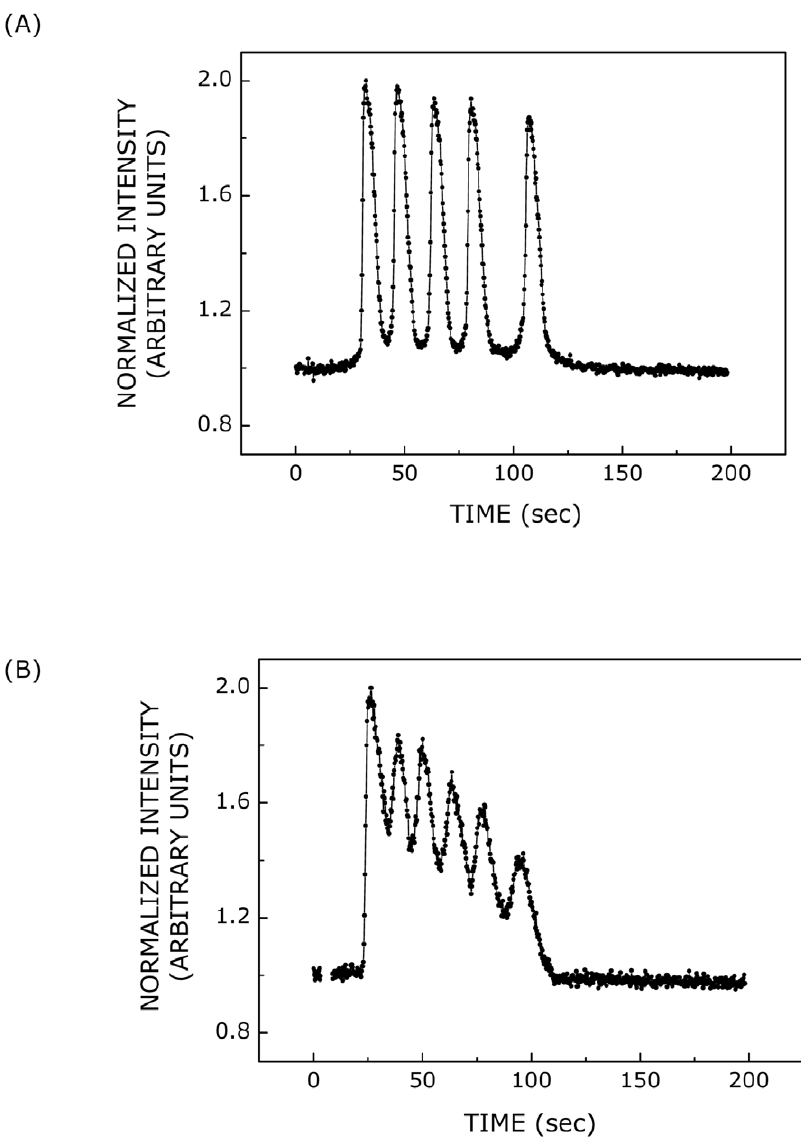
Figure 5. Calcium responses induced by ATP. Representative (A) distinct or (B) overlapping calcium spikes observed upon stimulation with 500 nM ATP. The propensity of the occurrence of overlapping calcium spikes increased with increase in ATP concentration. The temporal profile of calcium response was intensity-normalized such that the maximum and minimum (basal) intensities corresponded to values 2 and 1, respectively. See Materials and Methods for more